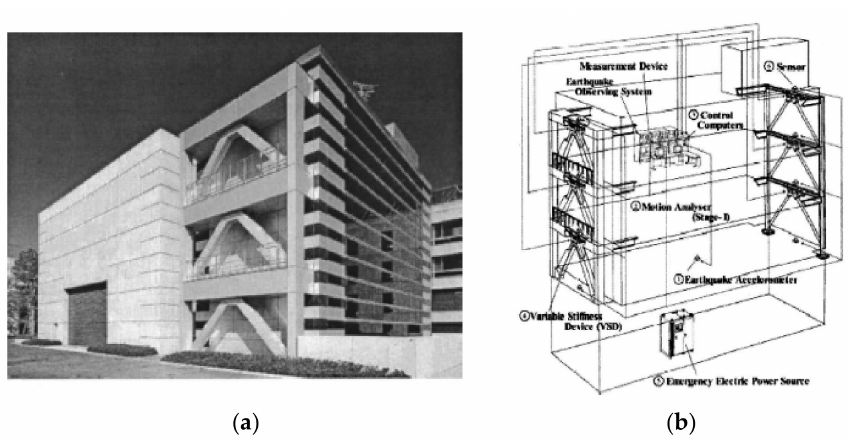
Figure 20. ( a ) Kajima Technical Research Institute with AVS system; ( b ) control scheme used in the Kajima Technical Research Institute [8].